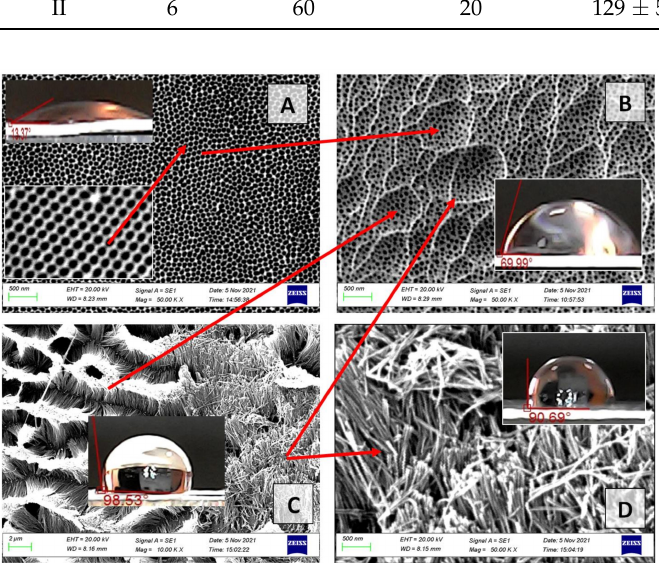
Figure 11. The SEM images of the outer surfaces (surface topology) for the PAA sample No. 4 of